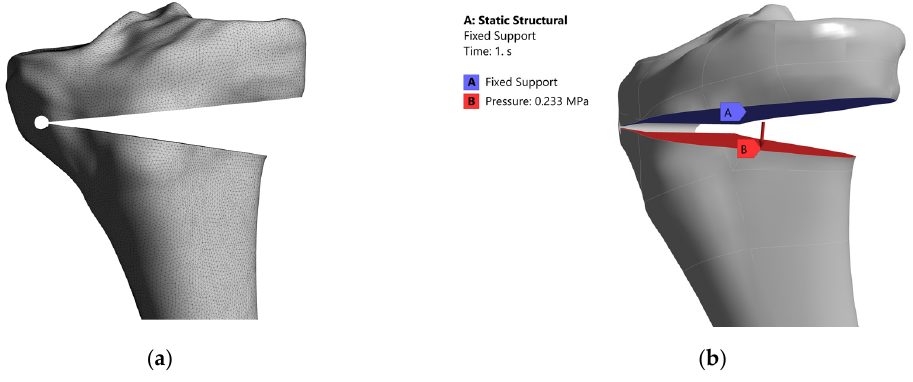
Figure 4. ( a ) Meshing the model and ( b ) application of stresses and constraints.